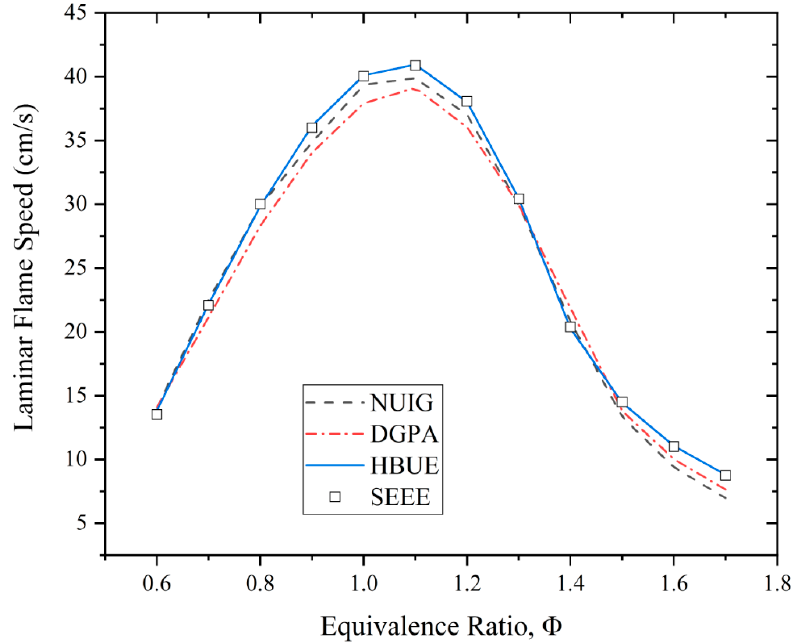
Figure 11. Comparison of the laminar flame speeds between NUIG, DGPA, HBUE, and SEEE at equivalence ratios of 0.6–1.7 and an unburned gas temperature of 298 K.